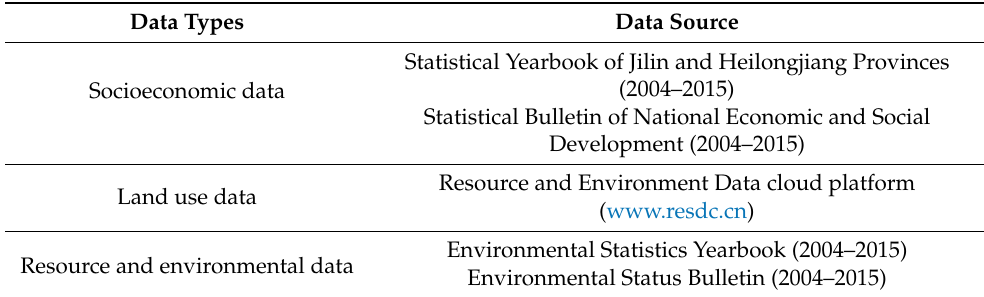
Table 3. Research data